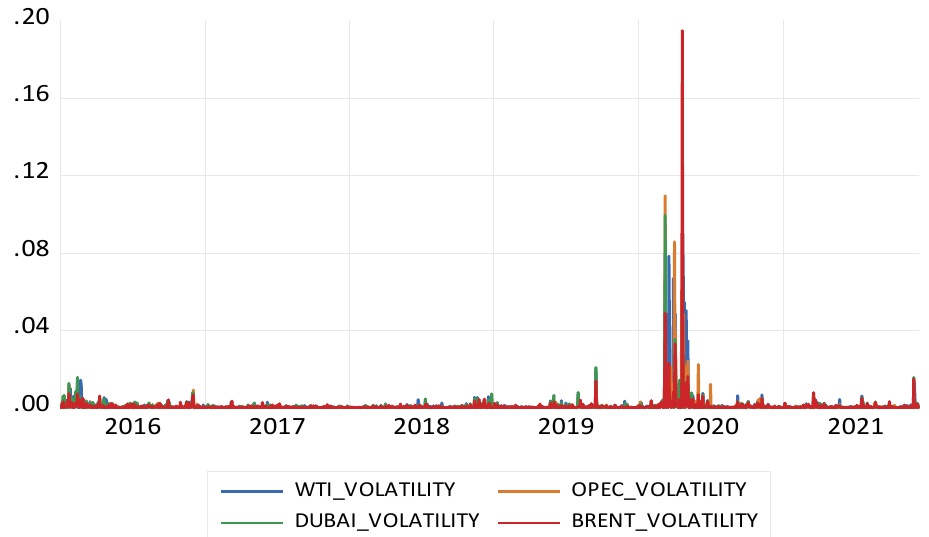
Figure 8. oil Benchmarks volatility clustering (sources Data Stream). Figure 8. Oil Benchmarks volatility clustering (sources Data